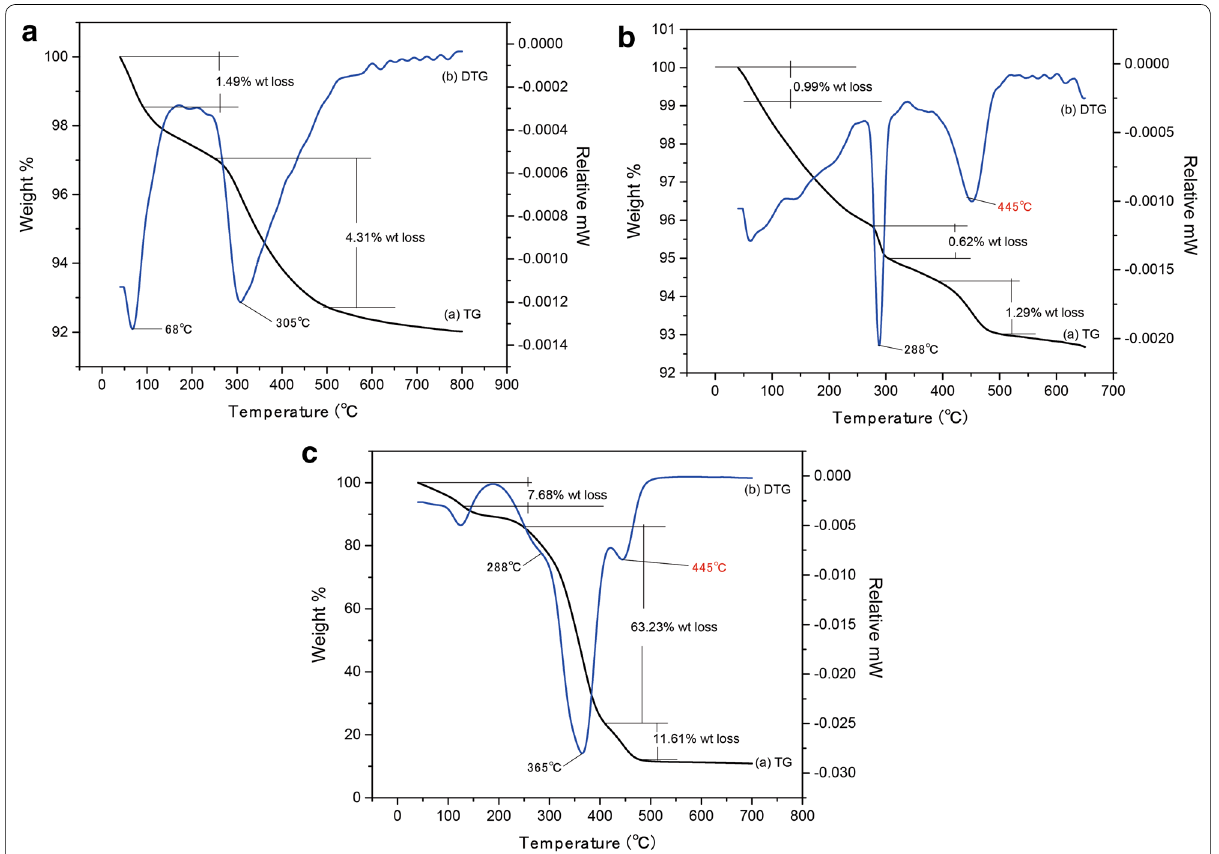
Fig. 6 The TGA-DTG curves of pristine ZnO NPs ~ 7 nm. a Lipid-coated ZnO NPs ~ 13 nm b and c